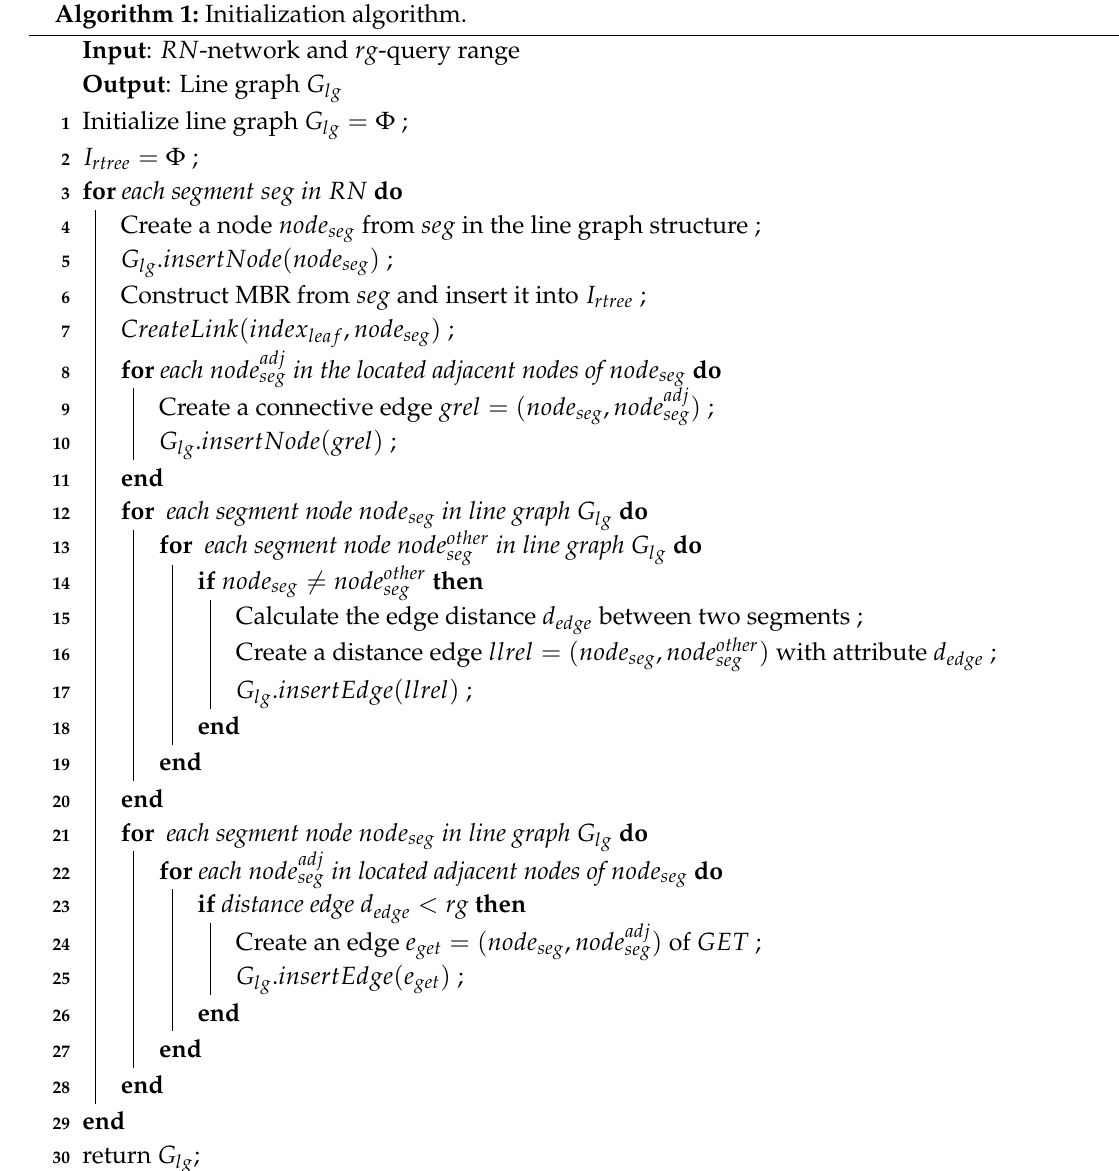
Algorithm 1: Initialization